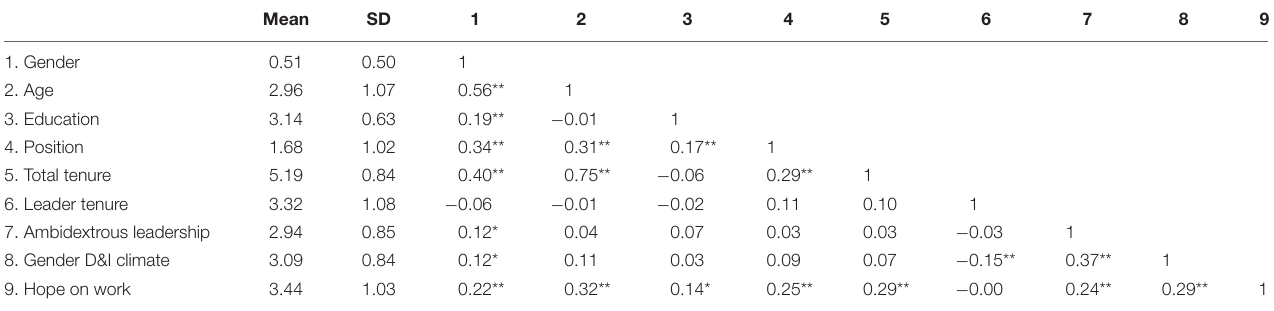
TABLE 1 | Descriptive statistics among variables ( N =